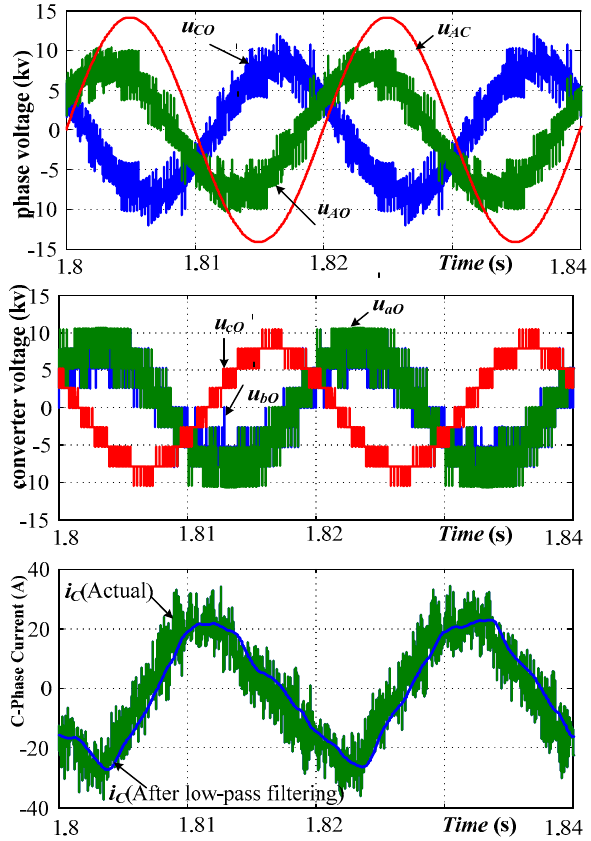
Figure 10. Original voltage and current without filtering at the full-power operation state.